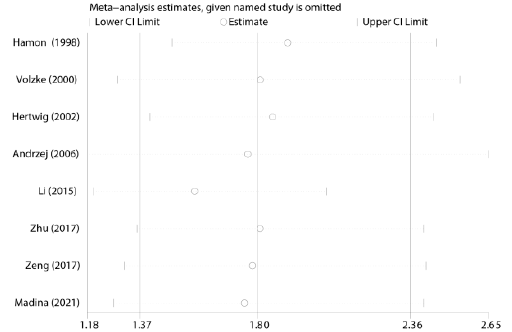
Figure 4. Sensitivity analysis of the pooled OR coefficients on the relationship between rs5186 polymorphism and risk of restenosis after PCI.CI = confidence interval, OR = odds ratio [13–20].